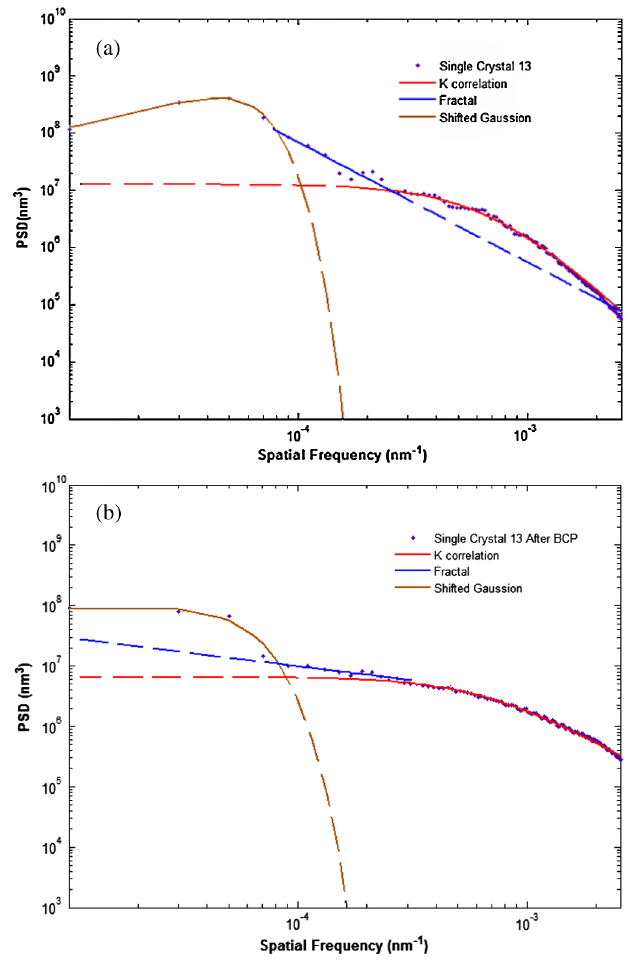
FIG. 11. Average one-dimensional PSD of single crystal 13, (a) as received and (b) after 30 (cid:1) m removal by BCP. The range of fitting for each component is indicated by the solid